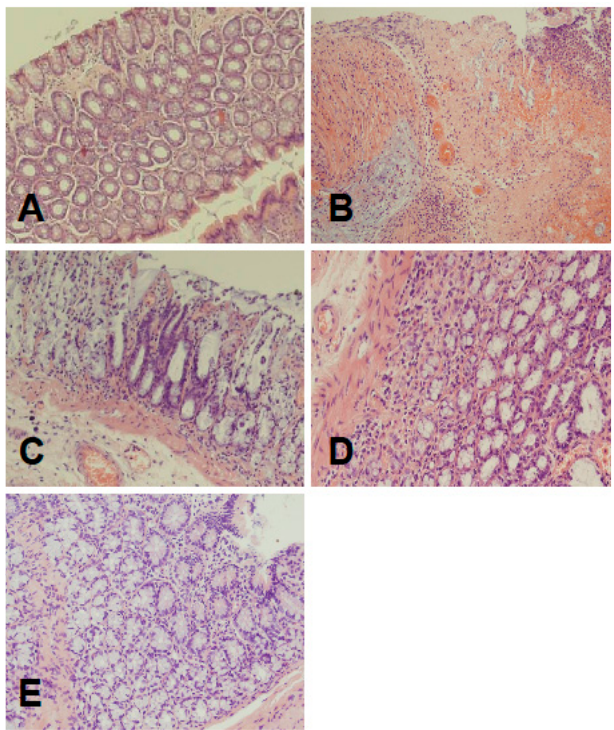
Figure 2. ( A ) Representative microscopic image of colonic mucosa observed in control rats without colitis; ( B ) representative microscopic image of colonic mucosa observed seven days after induction of colitis and i.p. treatment with saline; ( C ) representative microscopic image of colonic mucosa observed seven days after induction of colitis and i.p. treatment with ghrelin; ( D ) representative microscopic image of colonic mucosa observed 14 days after induction of colitis and i.p. treatment with saline; and ( E ) representative microscopic image of colonic mucosa observed 14 days after induction of colitis and i.p. treatment with ghrelin. Hematoxylin-eosin stain. Original magnification 400 × . Table 1. Effect of intraperitoneal administration of saline (NaCl) or ghrelin on morphological signs of colonic damage observed seven or 14 days after enema with saline or induction of colitis.